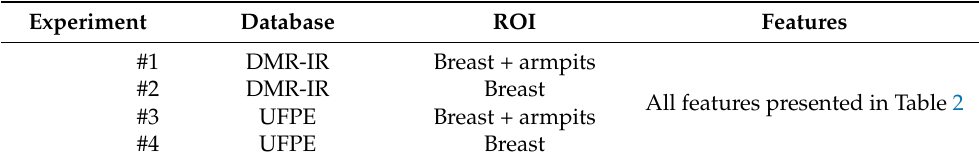
Figure 11. Samples of images from the used datasets, their default false colors and ROIs: ( a ) Image from DMR-IR dataset; ( b ) ROI based on the breast and linfonodes area using DMR-IR images; ( c ) ROI based only on the breast area using DMR-IR images; ( d ) Image from UFPE dataset; ( e ) ROI based on the breast and linfonodes using from UFPE images; ( f ) ROI based only on the breast area using UFPE images. Table 4. Main elements considered in the